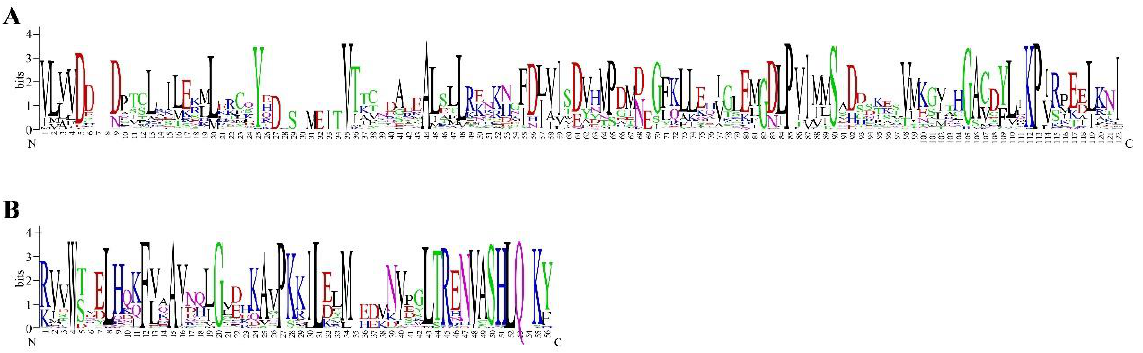
Figure 1. The conserved domains in type-B ARRs of B. napus . ( A ) The responsive regulator domain. ( B ) MYB_DNA-binding domain. Multiple sequence alignment of BnARRs were analyzed with Clustal X, and sequence logos were visualized by WebLogo 3.